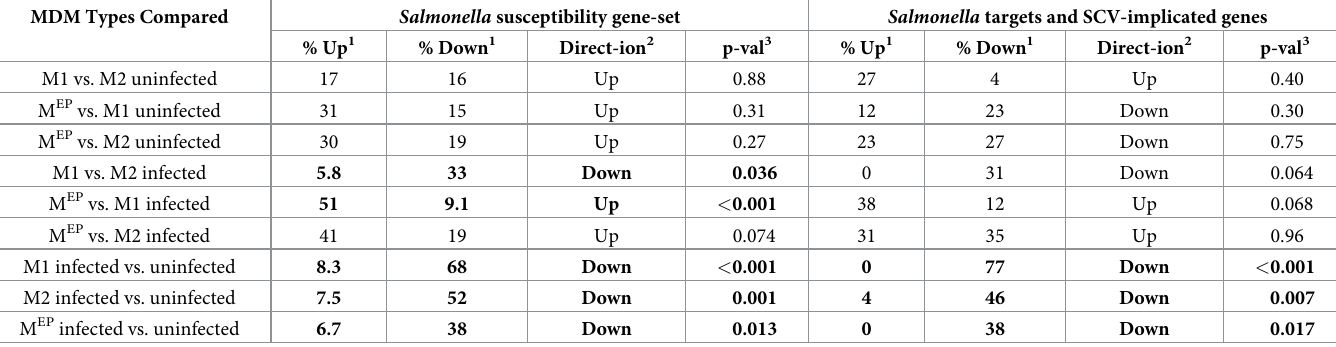
Table 2. Roast gene-set enrichment test for a set of 183 susceptibility genes [67] and a set of 31 Salmonella targets and SCV-implicated genes (S1 Table). MDM Types